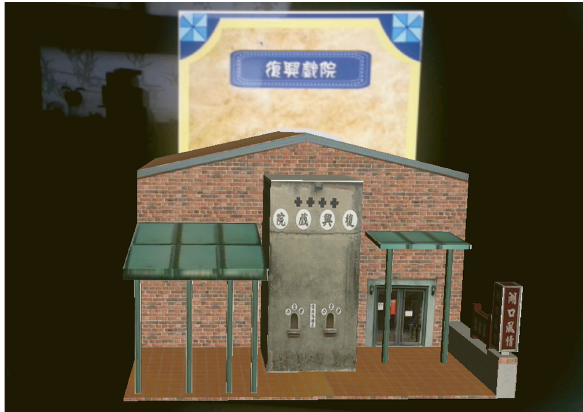
Figure 5. Scanning the front side of the board game card to reveal corresponding 3D building on the device screen